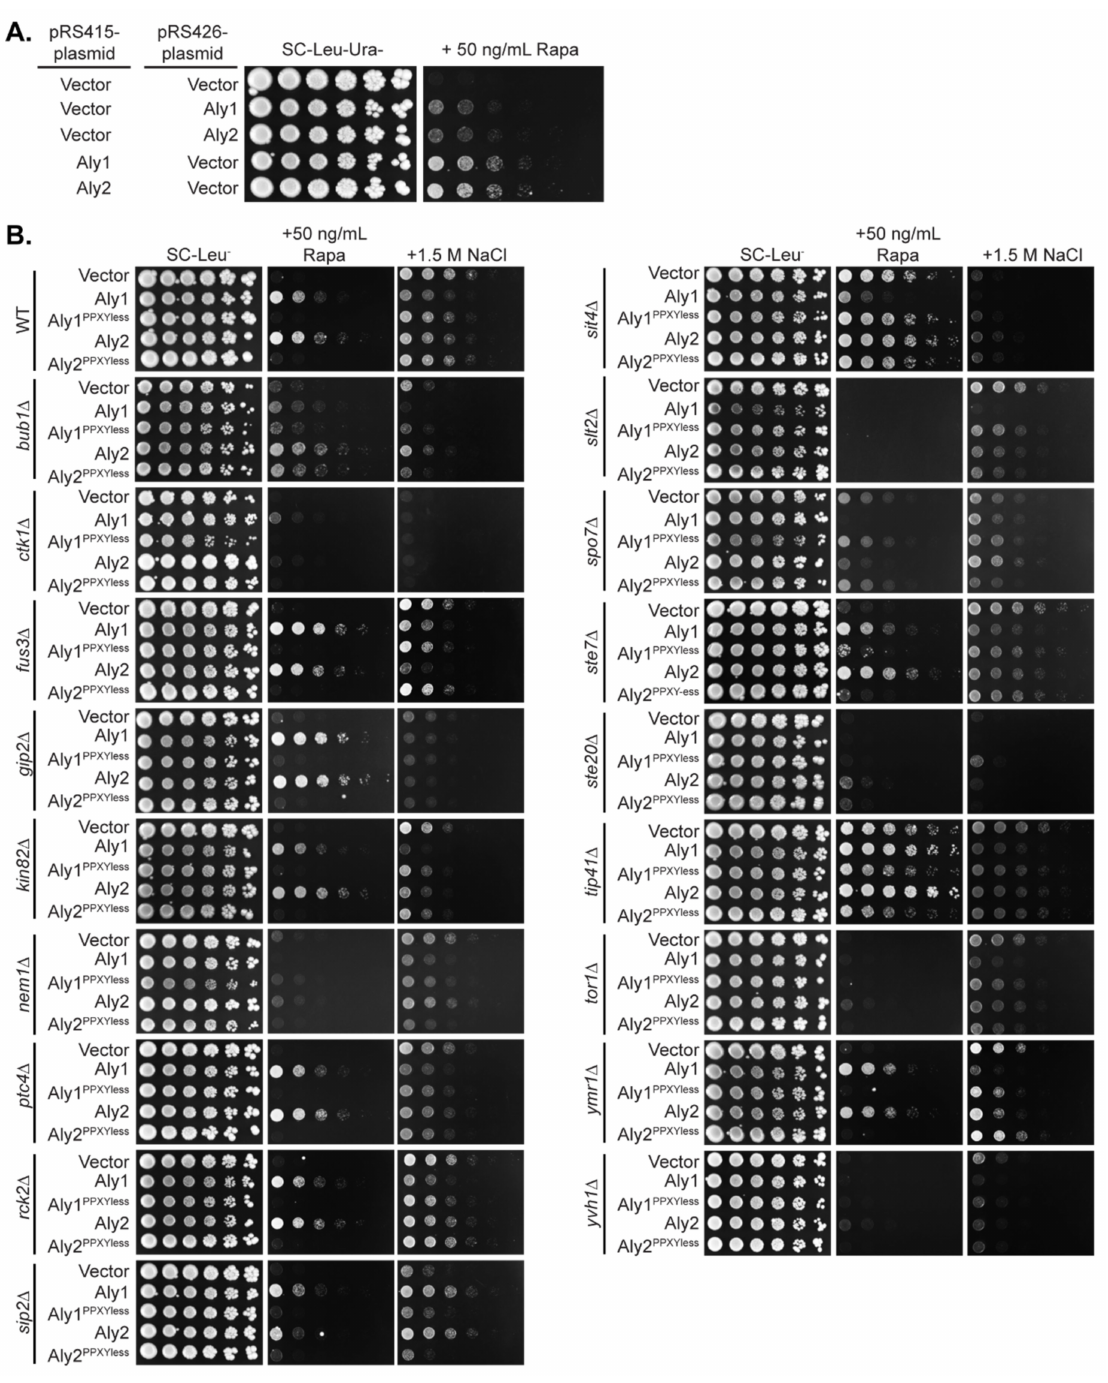
Figure 2. Secondary screening of KinDel candidates for growth phenotypes linked to Aly1- or Aly2- overexpression: ( A ) Serial dilution growth assay to compare the pRS426- ALY promoter-expressed α -arrestins to the pRS415- TEF1 promoter-expressed α -arrestins. Growth of serial dilutions of WT cells containing the indicated pRS426 or pRS415-derived plasmid expressing either nothing (vector) or the indicated α -arrestin. ( B ) Serial dilution growth assays of WT cells or those lacking the gene indicated (from the KinDel library) and containing the indicated pRS415- TEF1pr -derived plasmid on the medium